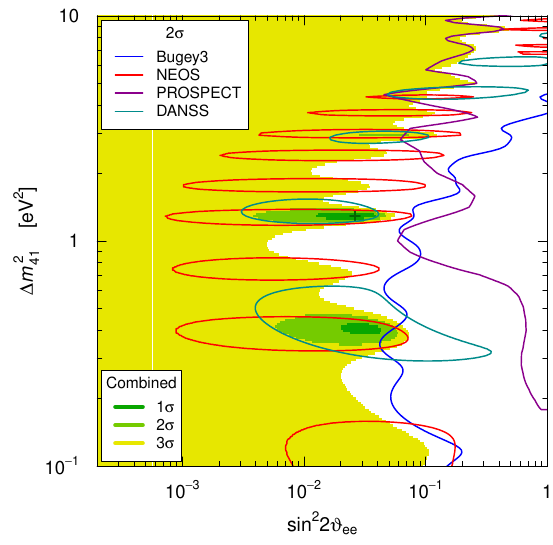
Figure 3 . Contours of the 2 (cid:27) regions in the (sin 2 2 # ee ; (cid:1) m 2 spectral ratio measurements of the Bugey-3, NEOS, PROSPECT and DANSS experiments. The shadowed regions are allowed by the combined (cid:12)t, with the best (cid:12)t point indicated by the cross.